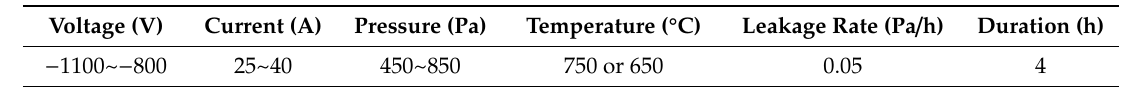
Table 3. Detailed parameters of plasma nitriding.